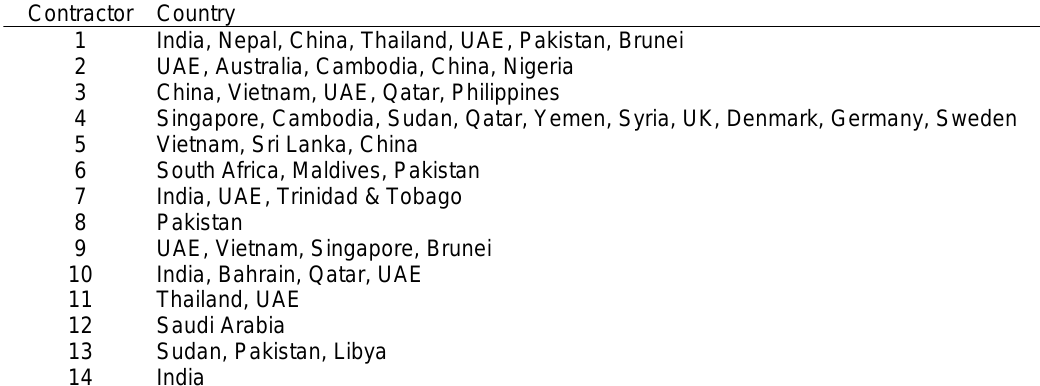
Table 2: Countries penetrated by surveyed Malaysian contractors